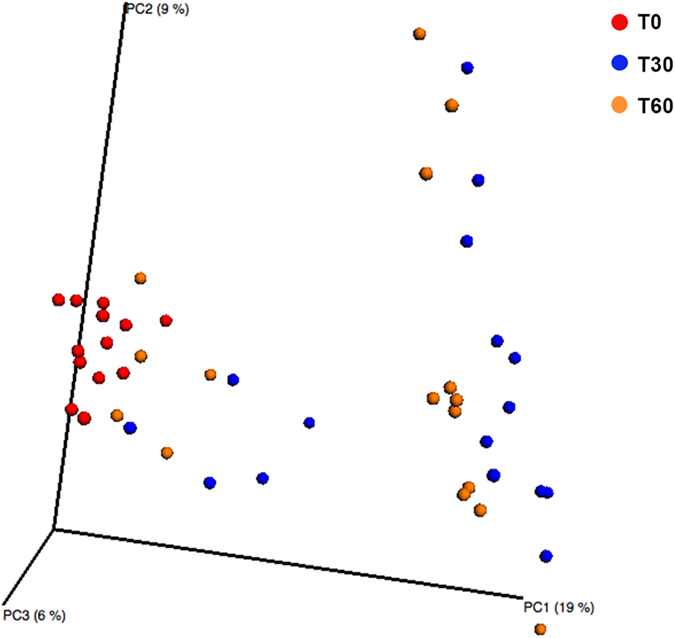
Principle Coordinate Analysis (PCoA).The analysis was based on unweighted UniFrac distance matrix of all 16S rRNA gene sequences found on salivary samples of Saharawi celiac children under African-style gluten-free (T0), and after 30 (T30) and 60 (T60) days of intervention with Italian-style gluten-free diet.